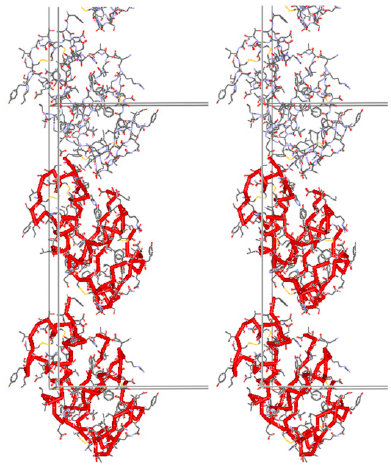
Figure 2. Packing of three insulin dimers arranged alongside c axis in T 3 R 3f DC structure. A Ca trace is colored red and unit ‐ cell boundaries are also visible (Reproduction of Figure 4 from reference [60]. Reproduced with permission of the International Union of